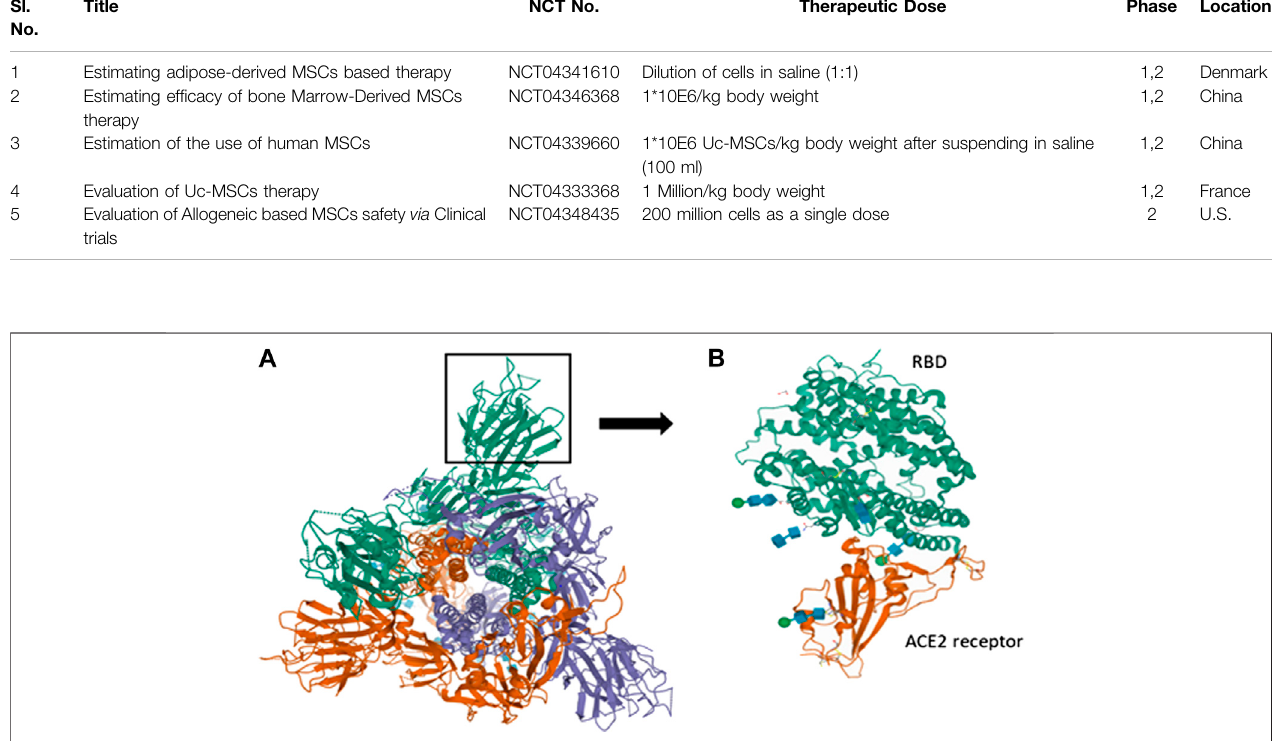
FIGURE3| SpikeinteractionswiththeACE2receptorofthehost.(A)Representsthepre-fusionstructureofSglycoproteinofSARS-CoV-2(PDBID-6VSB).Ithasa predominant state of trimers with receptor accessible conformation of one of the three RBD due to the upward rotation. The structure represents three chains (A represented in green color, B represented in violet color and C represented in red color); (B) Represents the crystal structure of SARS-CoV-2 spike RBD bound with ACE2 receptor of humans (PDB